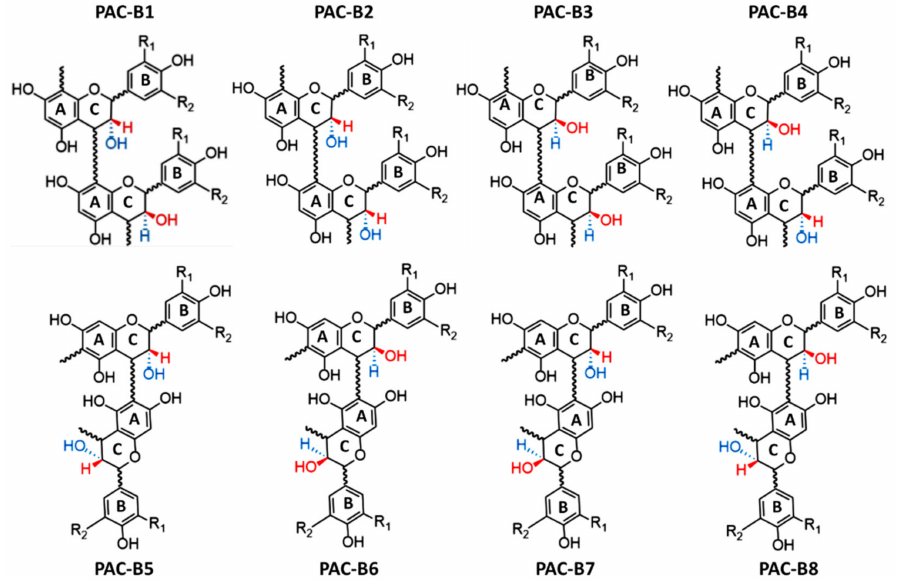
Figure 3. Chemical structures of the different B-type PACs, depending on the stereochemistry of substituents. The blue dashed line represents bonds that "sink" below the plane of the sheet, while the red wedged line indicates a chemical bond that is directed towards the observer.